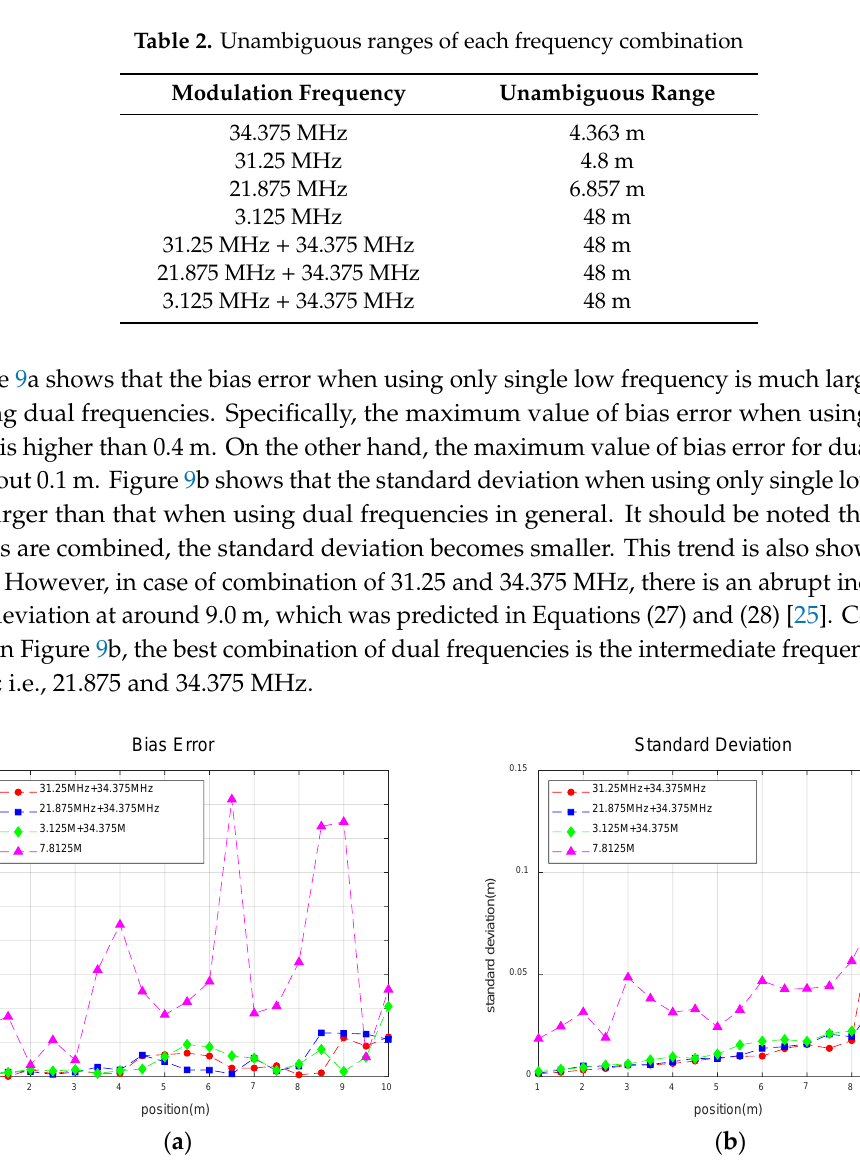
Figure 9. ( a ) Bias error for each frequency combination; ( b ) standard deviation for each frequency combination.